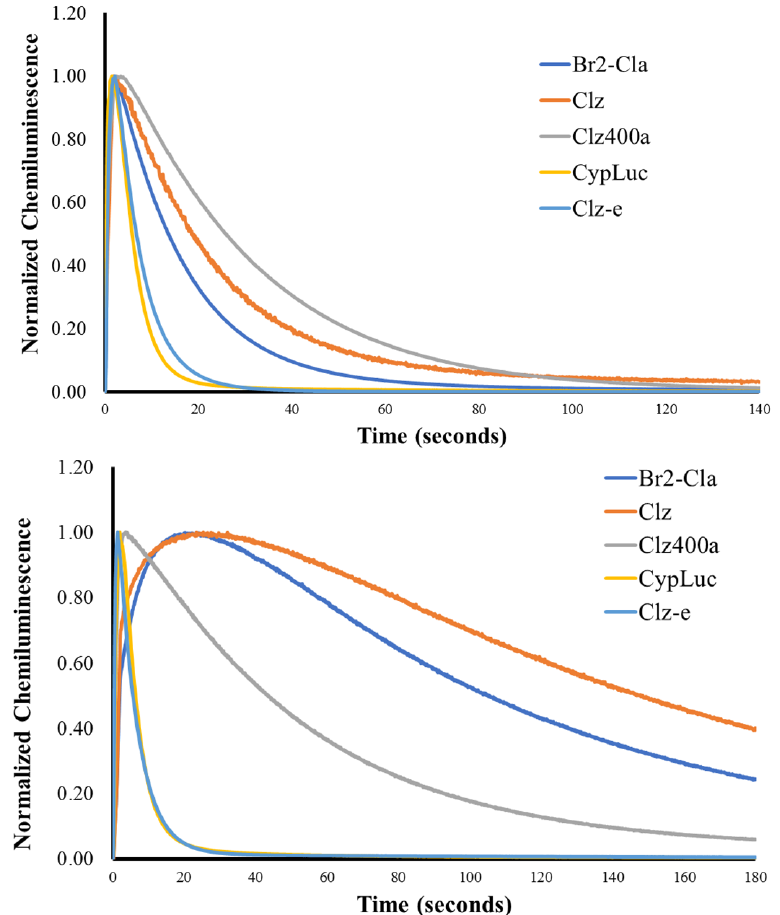
Figure 2. Normalized CL emission as a function of time (in seconds) for Br2-Cla, Clz, Clz400a, CypLuc and Clz-e, in DMSO ( top ). Normalized CL emission as a function of time (in seconds) for Br2-Cla, Clz, Clz400a, CypLuc and Clz-e, in DMF ( bottom ). All assays were performed with a concentration of 0.73 µ M for all compounds.